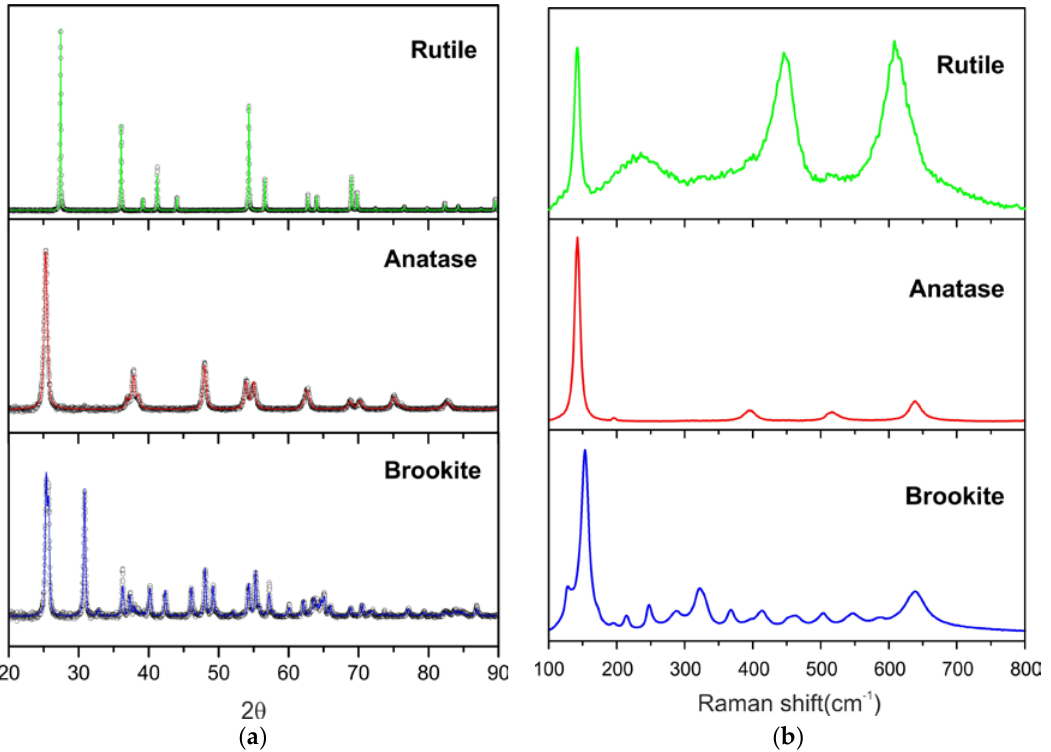
Figure 1. ( a ) XRD patterns (colored dots) and Rietveld analysis (black lines) of pure rutile, anatase and brookite (reproduced from [21] with the permission of the Elsevier, 2017) and ( b ) corresponding Raman spectra.